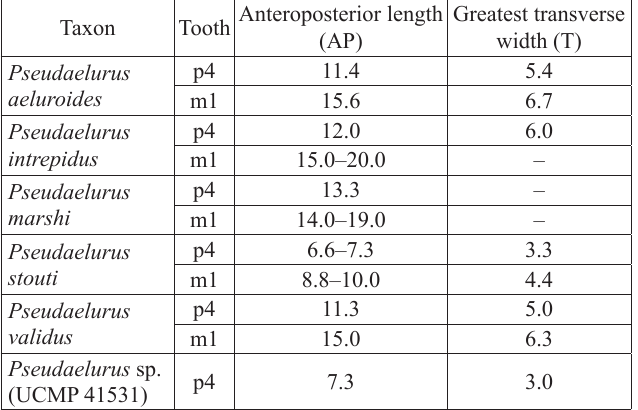
Table 4. Measurements (in mm) of p4 and m1 of Pseudaelurus spp. from the Barstovian (Miocene) of North America (from Rothwell 2003, except P . aeluroides from MacDonald 1954 and UCMP 41531 from Smith 2002).